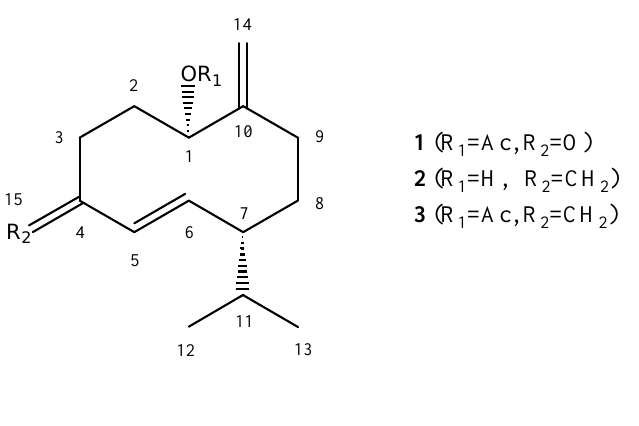
Figure 1. Structures of compounds 1 - 3